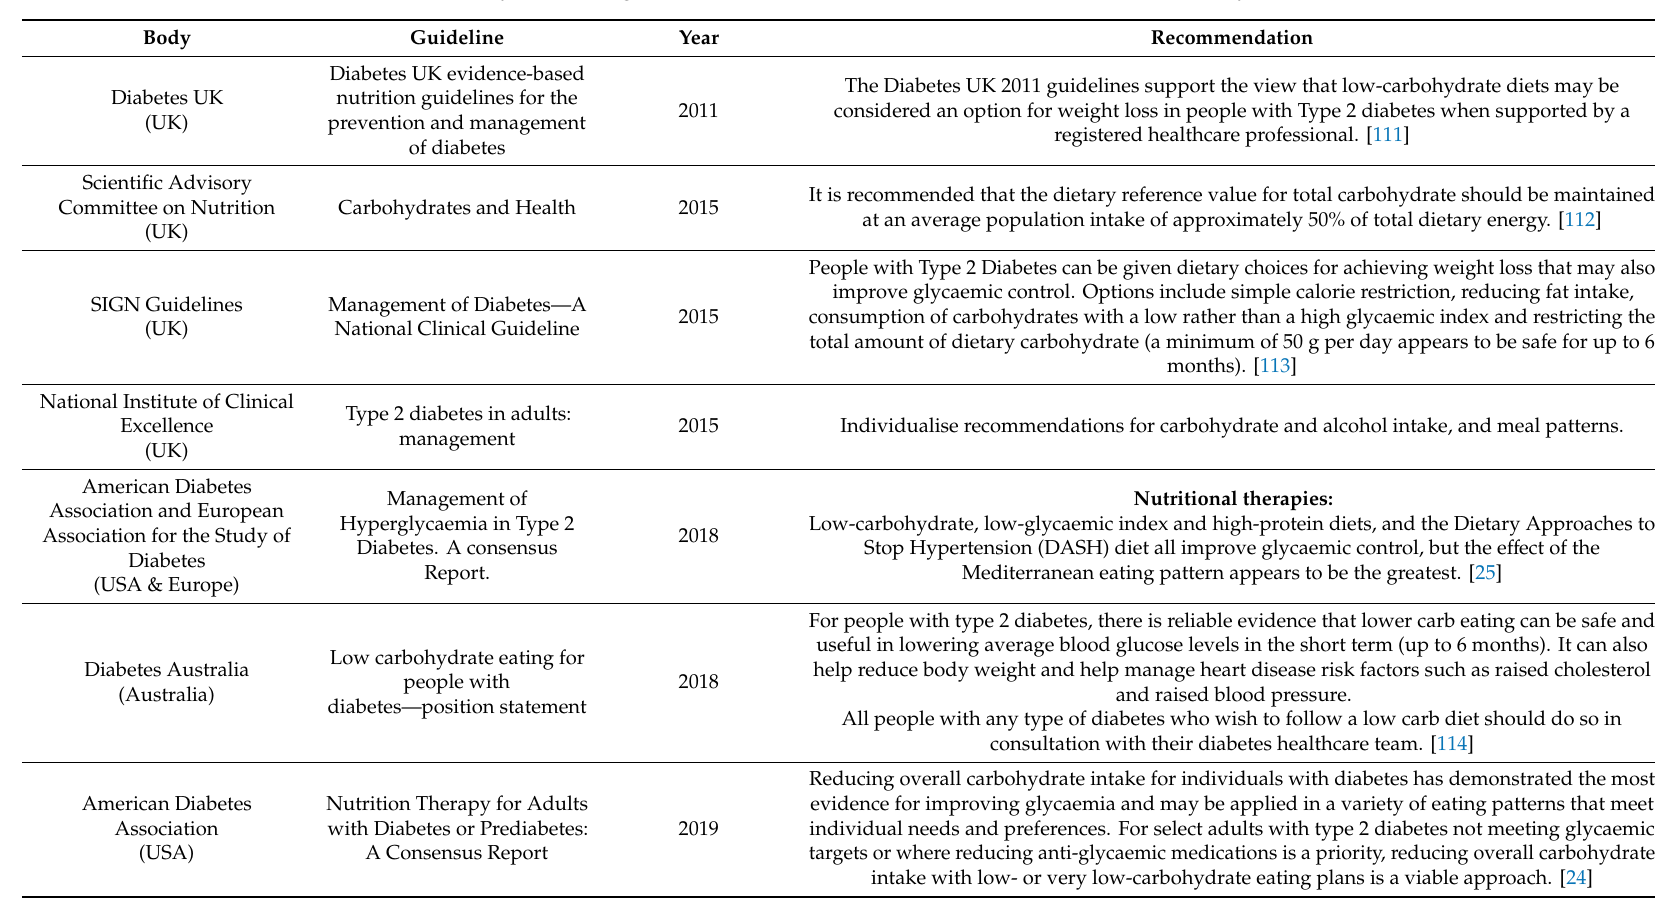
Table 2. Summary of current guidelines and consensus statements on the use of low-carbohydrate